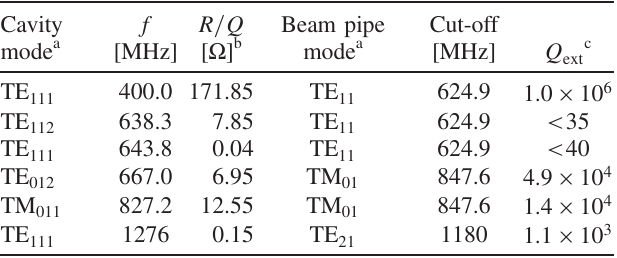
TABLE V. HOMs of the